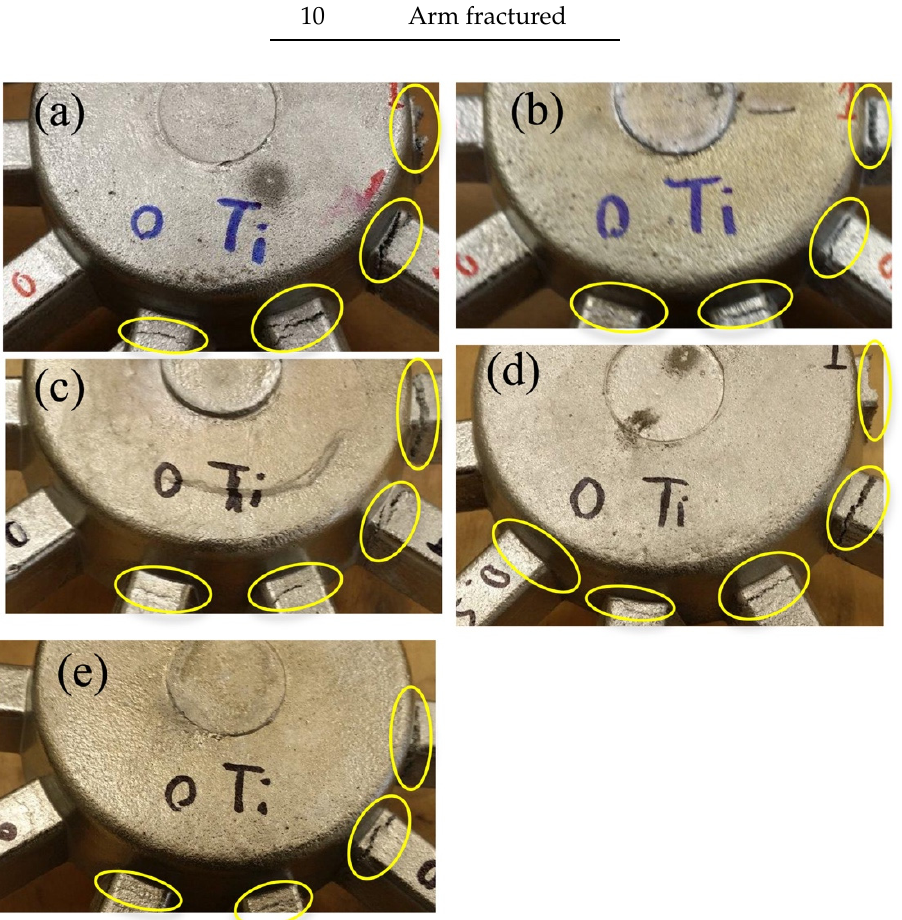
Figure 5. Pictures of representative multi-arm castings without grain refining: ( a ) DA1, ( b ) DA2, ( c ) DA5, ( d ) DA6, and ( e )